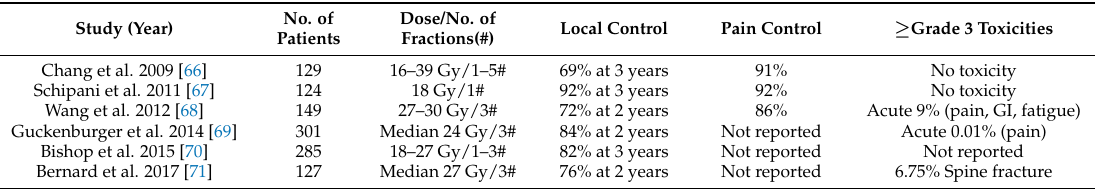
Table 4. Spine SBRT